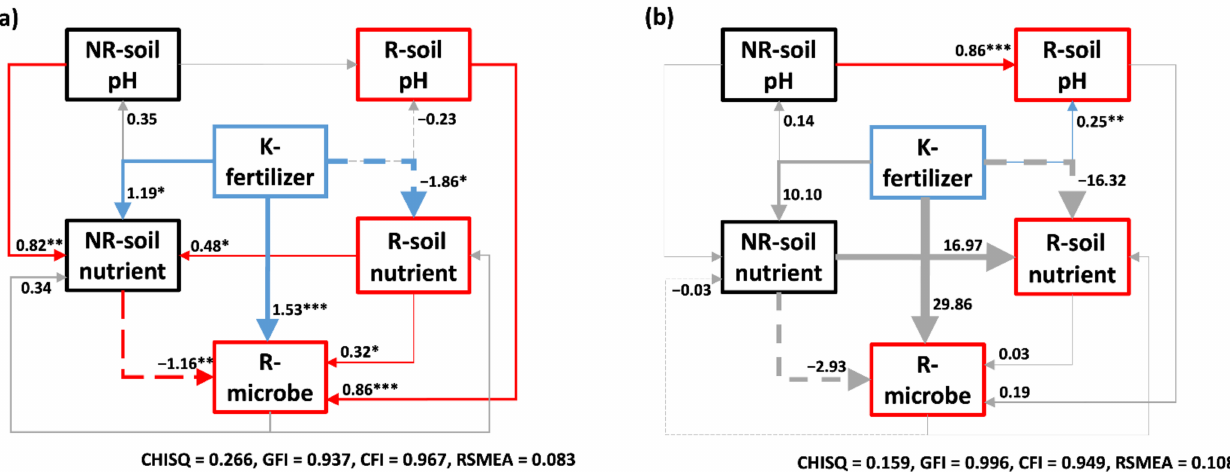
Figure 7. Structural equation modeling (SEM) about the effect of K supply level on soil properties of the rhizosphere (R) and non-rhizosphere (NR) and rhizosphere microbe and their interaction and relationships under ( a ) water-limited conditions and ( b ) water-unlimited condition. SEM are colored according to classification (blue for K-effect, red for R-region, and black for NR-region, while gray lines represent non-significant coefficients ( p > 0.05). Full lines represent positive relationships, while dotted lines represent negative relationships, which the width of lines indicates the strength of the relationship. *** p < 0.001; ** p < 0.01; * p <